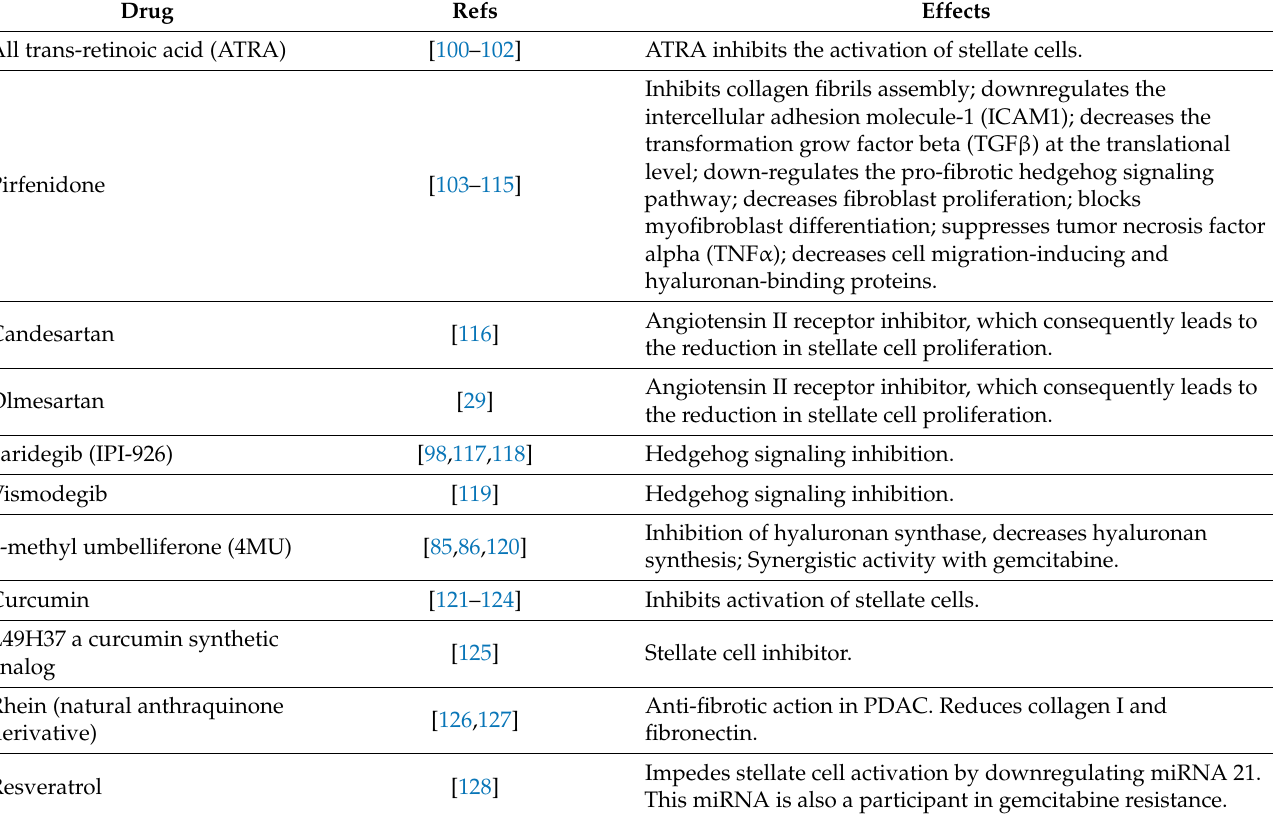
Table 1. List of useful drugs for targeting desmoplastic